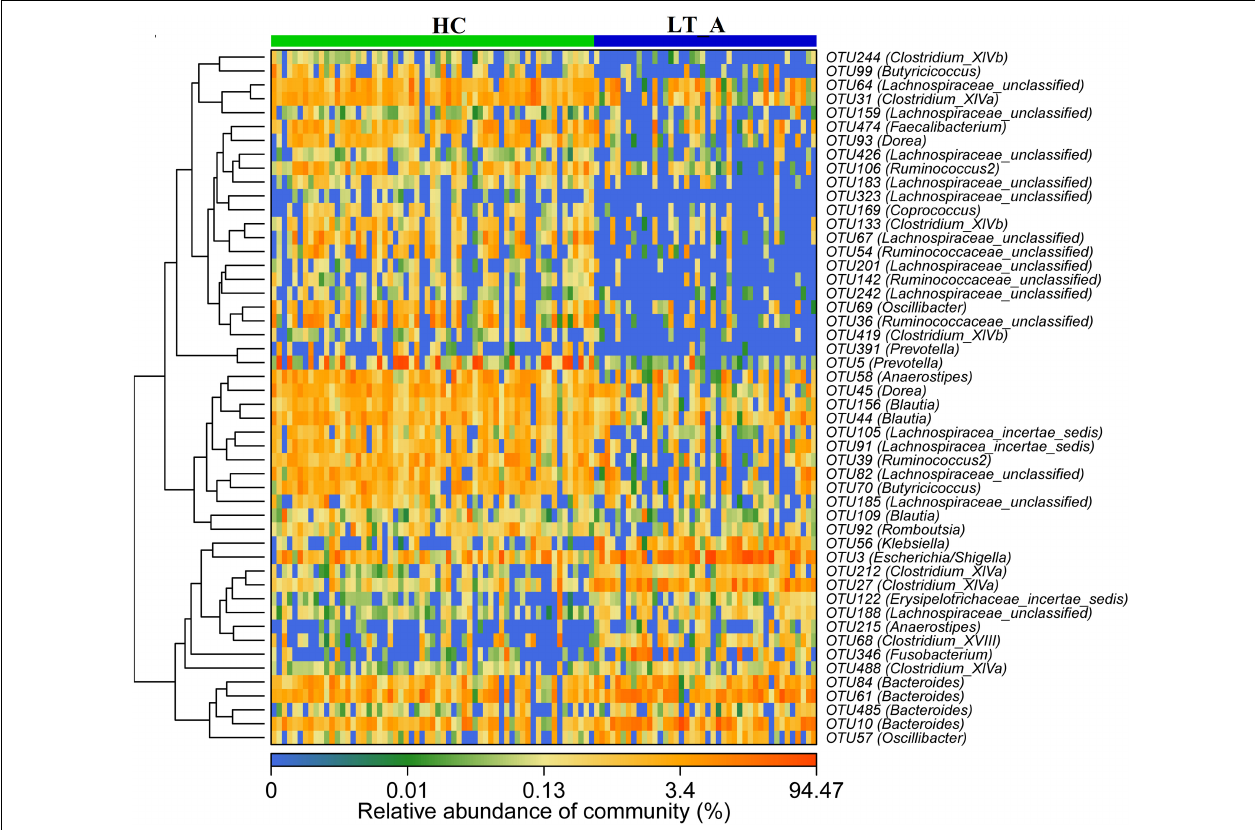
FIGURE 3 | Heat maps showing the relative abundance of the discriminatory OTUs that drive the differences between groups LT_A and HC. For each sample, the columns show the relative abundance data for the discriminatory OTUs listed to the right of the figure. Abundance values for each of the genera were clustered using unsupervised hierarchical clustering [the relative abundance of each genus is indicated by a gradient of color from blue (low abundance) to red (high abundance)]. The corresponding genus of each key OTU is noted to the right of the figure. The heat map on the left shows Spearman hierarchical clustering of relative abundance values for each of the 50 most discriminatory 97%-identity OTUs in a random forest-based model of the fecal microbiota of the LT_A and HC groups. LT_A, fecal microbiomes of the liver recipients with abnormal liver function; HC, fecal microbiomes of the healthy control group; OTU, operational taxonomic